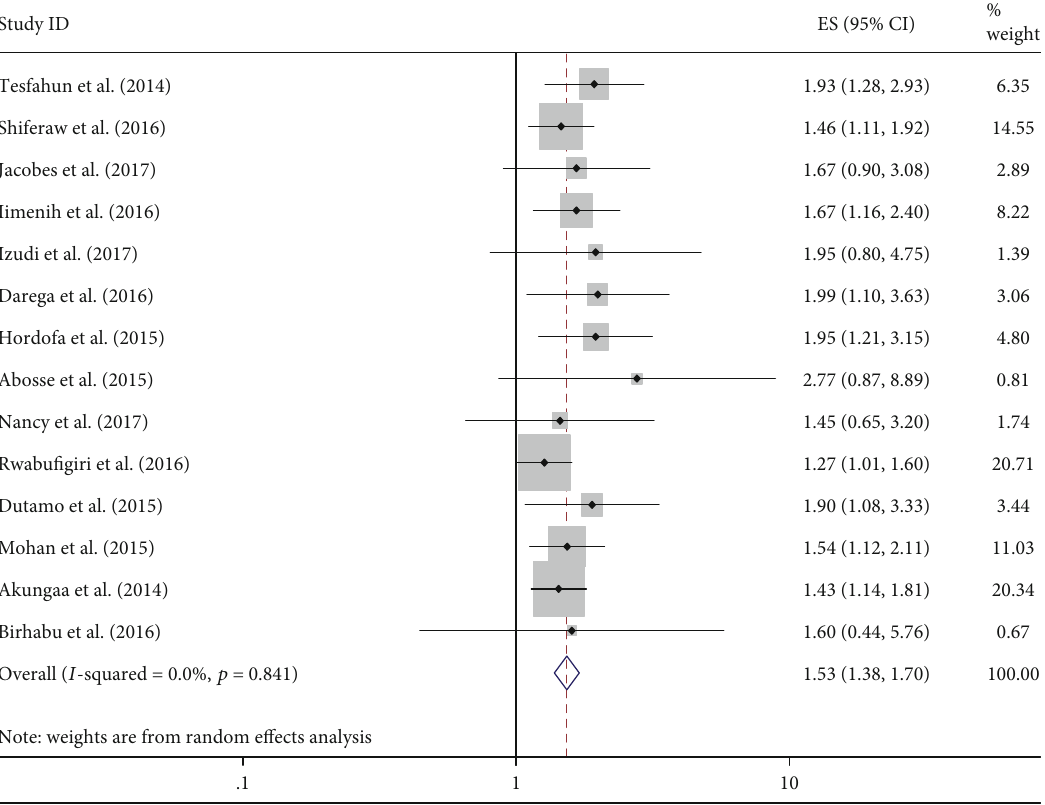
Figure 2: Forest plot shows the e ff ect of antenatal care use on postnatal care service utilization. The midpoint and the length of each line segment indicate odds ratio and 95% con fi dence interval, respectively, whereas the diamond shape indicate the overall pooled estimate of odds ratio for the fourteen